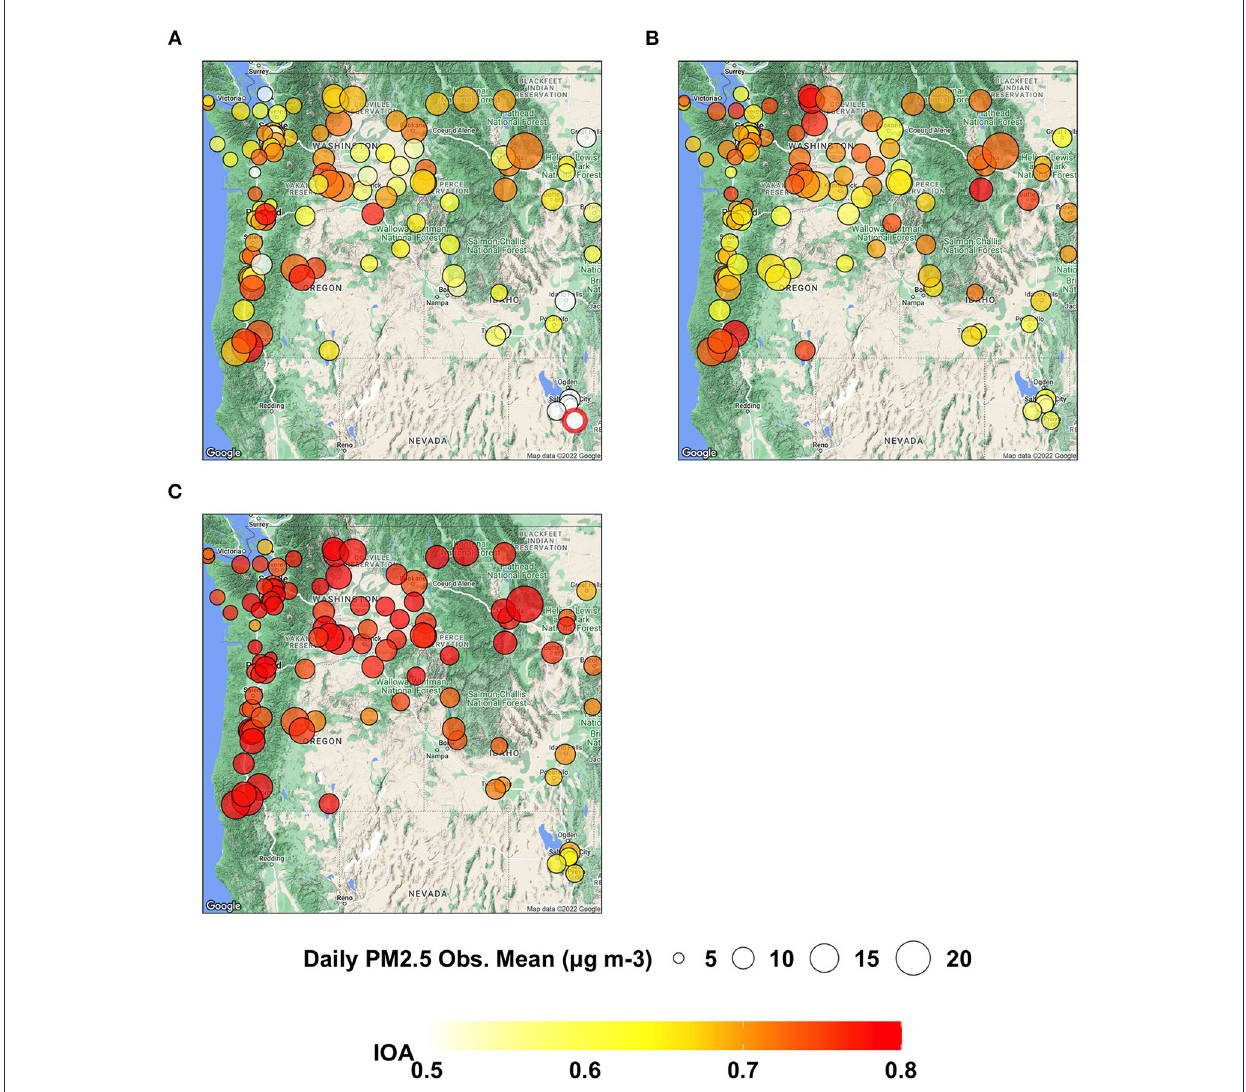
FIGURE8 Maps showing IOA of daily PM2.5 predictions from (A) AIRPACT, (B) ML1, and (C) ML2 at the AQS sites throughout the PNW in the wildfire season of 2017 to 2020.